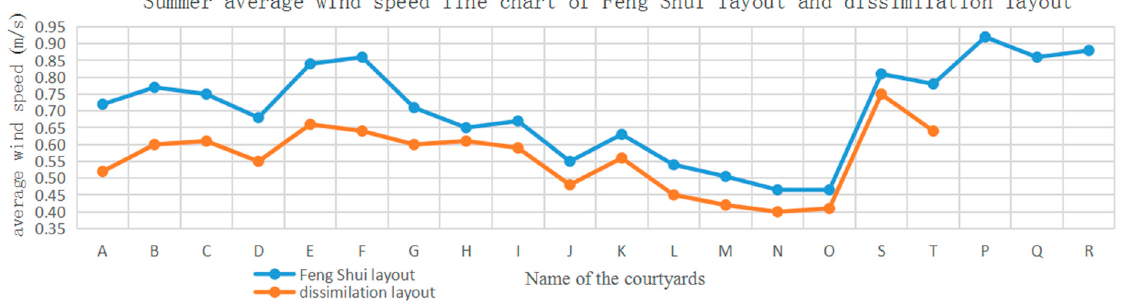
Figure 9. The regression analysis of the summer average wind speed for the courtyards of feng shui layout and dissimilation layout. The values of the figure was based on CFD simulation results. (2) The comfortable wind speed zone cloud charts show that the maximum wind speeds of both layouts were less than 2.90 m/s, and the ratio of the strong wind speed zone was 0%. The white zone in the figure is the zone where the wind speed was less than 0.70 m/s, that is, “the low wind speed zone”. The ratio of the comfortable wind speed zone was then obtained and a broken line chart was plotted for both layouts (Figure 10, the courtyard names are from Figure 7a,d).